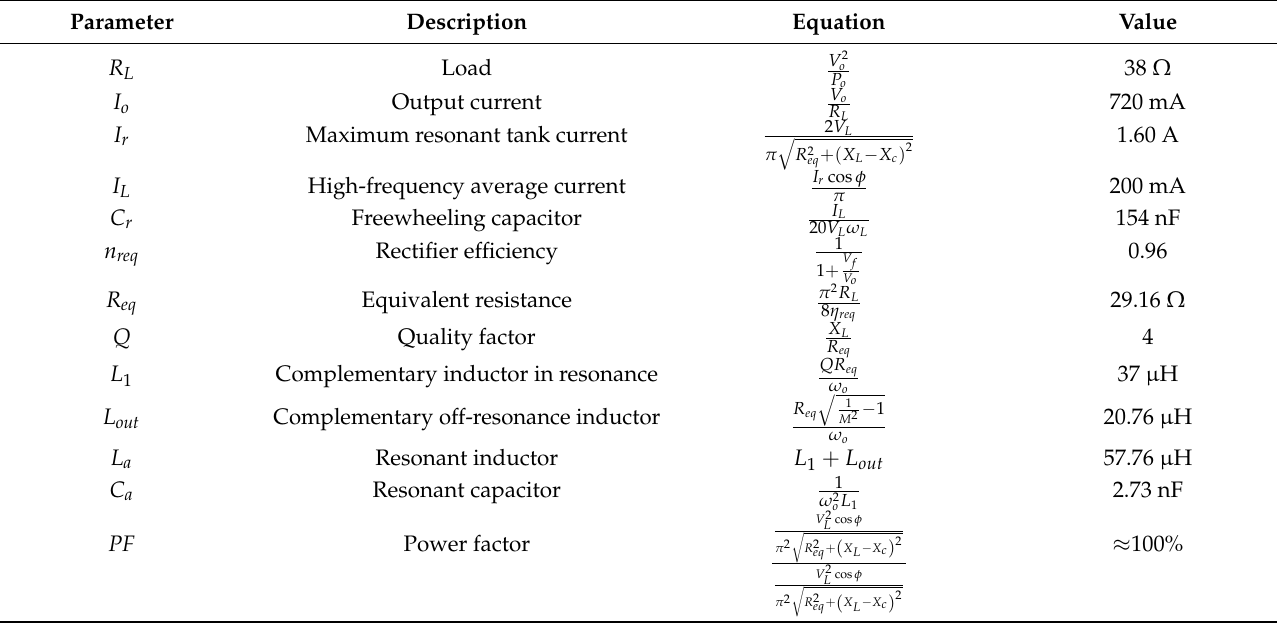
Table 2. Design methodology for a switching frequency of 500